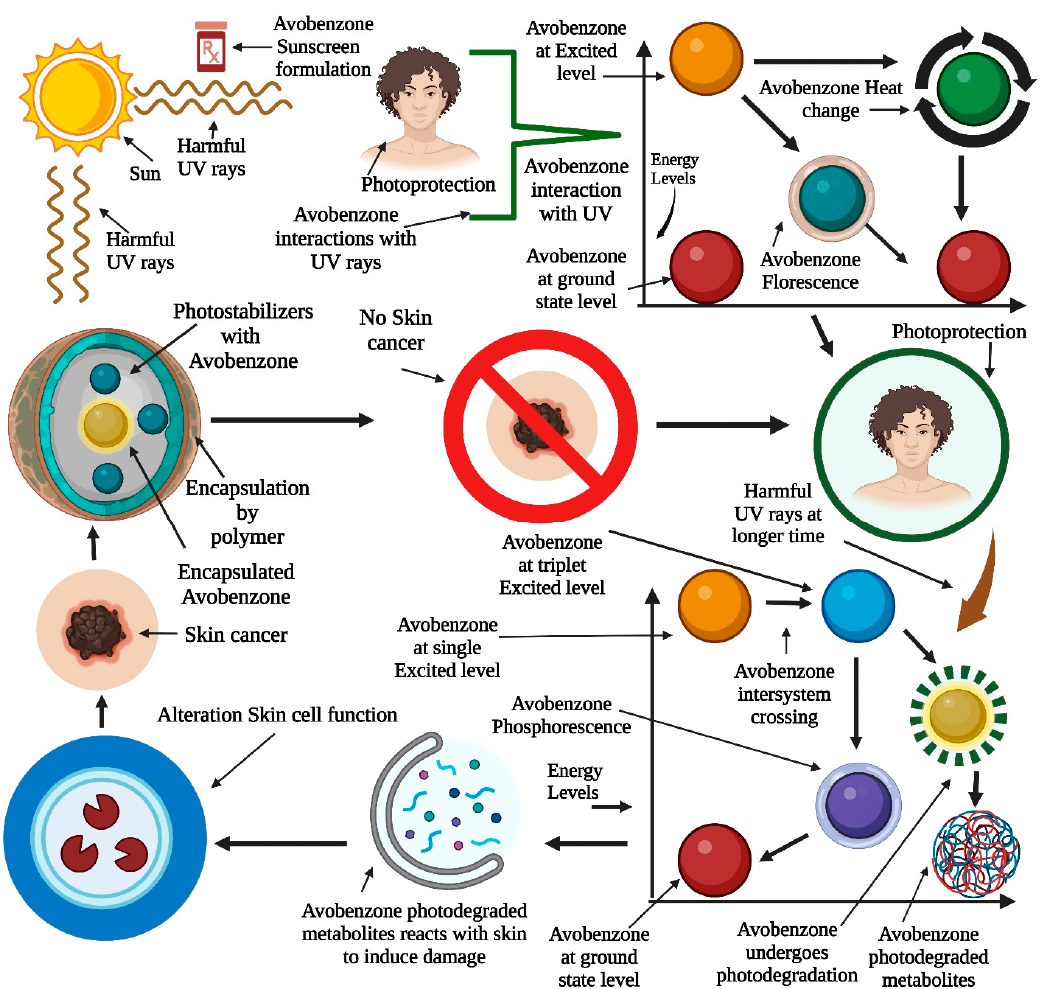
Figure 4. Schematic representation of sunscreen agent-loaded micro/nanocarriers wherein the delivery systems that surround the sunscreen agent prevent skin penetration and limit exposure to possibly dangerous substances. Encapsulation and photostabilizer compounds are used to make photostable formulations for photounstable UV filters such as AVOB. Generally, a stable UV filter after UV ray exposure undergoes an excited state and returns to a stable ground state by using phosphorescence and fluorescence. After prolonged UV exposure, such UV filters undergo interstate system crossing to form photograded metabolites, which further induce skin cancer. The effect of quercetin on the photostability of AVOB was investigated by Scalia et al. [50]. They have demonstrated that quercetin was highly effective when used at lower concentrations than commonly used stabilizers (octocrylene) and antioxidants (vitamin E). Elisa C. Felippim et al. fabricated a nanoencapsulation of a quercetin photoprotective formulation. Harmful reactive oxygen species are generated in the skin and damage skin cells due to harmful UV radiation. Authors use quercetin as an alternative antioxidant in sunscreens, which provides additional skin photoprotection. Quercetin has stability and permeation problems, so it is encapsulated in nanoparticles to improve stability and skin